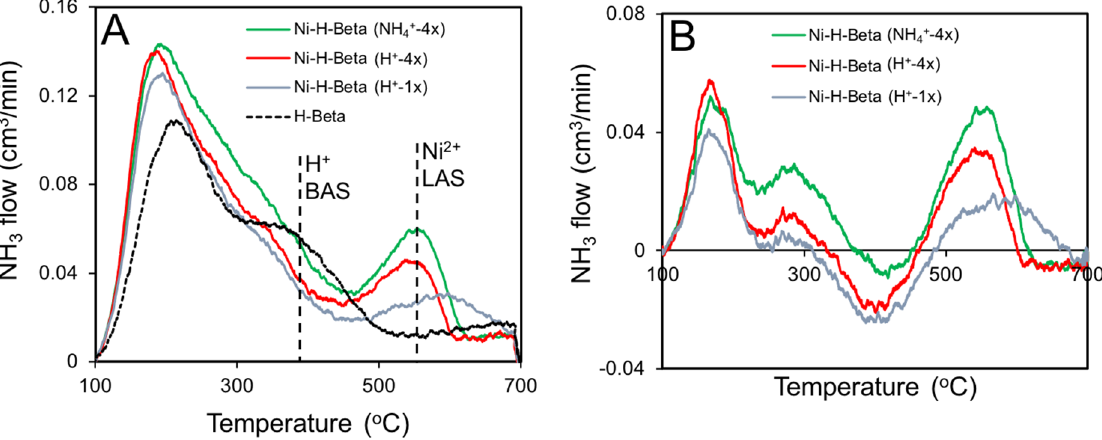
Figure 7. ( A ) NH 3 TPD spectra of H-Beta and Ni-H-Beta catalysts after in situ pretreatment at 500 °C and ( B ) TPD difference spectra (subtracting H-Beta reference).